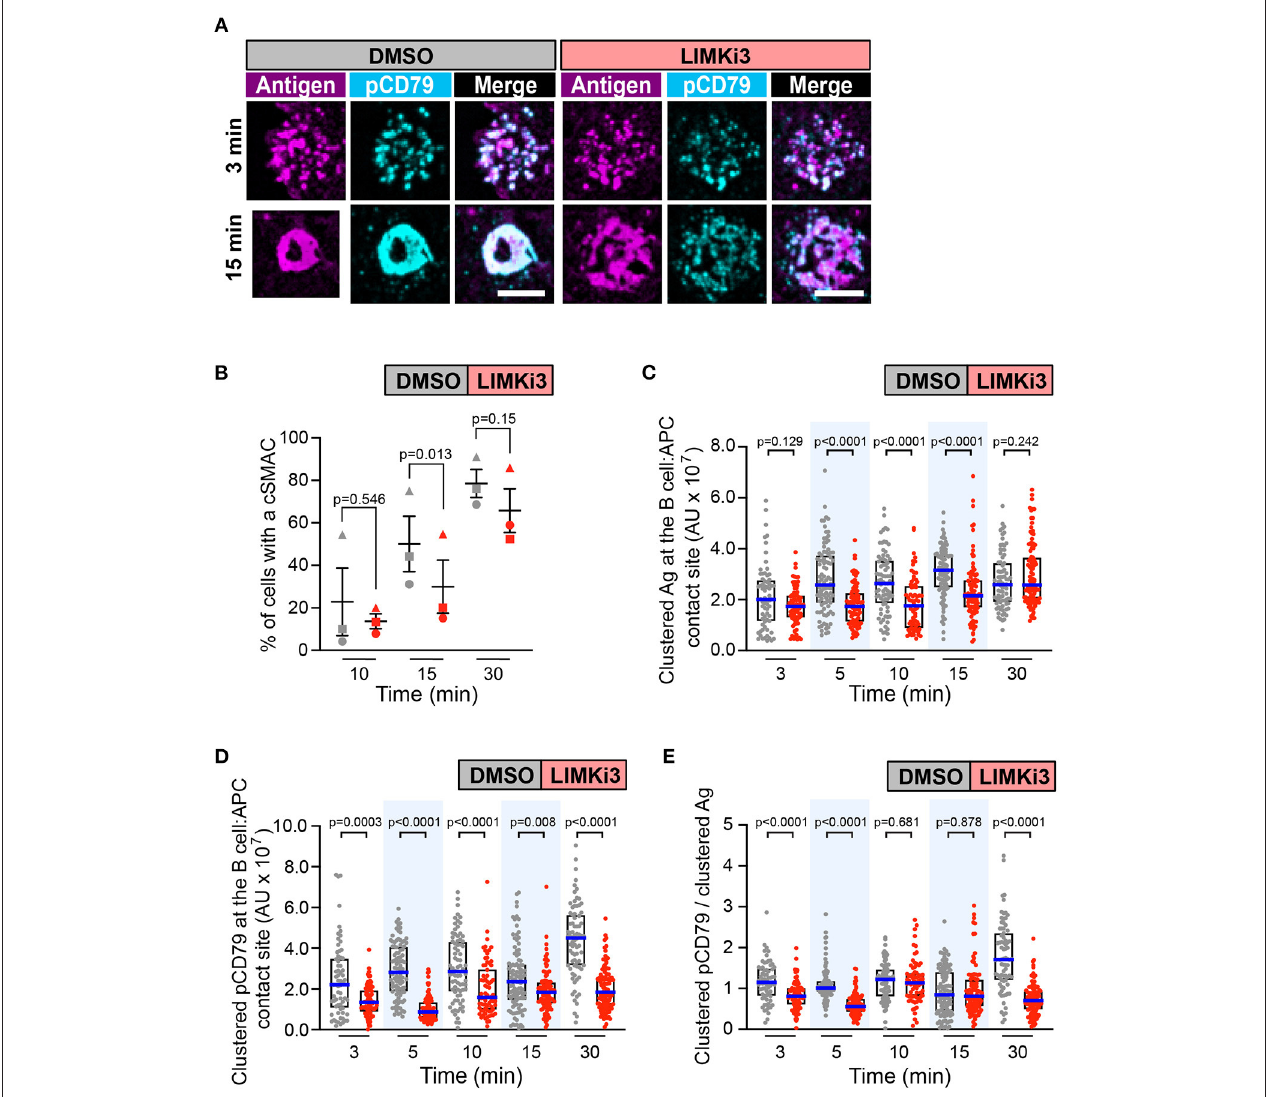
FIGURE 7 | Inhibiting LIMK in A20 D1.3 B cells impairs cSMAC formation and BCR signaling at the immune synapse. A20 D1.3 B cells were pre-treated for 1h with DMSO or 50 µ M LIMKi3 before being added to mHEL-HaloTag-expressing COS-7 APCs. The cells were then fixed at the indicated times and the B cell-APC interface was imaged by spinning disk microscopy. (A) Representative images. Scale bars: 5 µ m. (B) For each time point, the percent of cells that had formed a cSMAC is graphed. Each symbol represents an independent experiment. Paired t -tests were used to calculate p-values. (C,D) The total fluorescence intensity of the mHEL-HaloTag Ag (C) or pCD79 (D) that was present in clusters at the B cell-APC contact site was quantified for each cell. Each dot is one cell. n > 67 cells per condition. The median (blue line) and interquartile ranges (black box) are shown. (E) For each B cell represented in (C,D) , the total fluorescence intensity of clustered pCD79 was divided by the total fluorescence intensity of clustered Ag. The median (blue line) and interquartile ranges (black box) are shown. The data in (C–E) are from the same experiment, which is representative of three independent experiments. The Mann-Whitney U test was used to calculate p-values for (C–E)